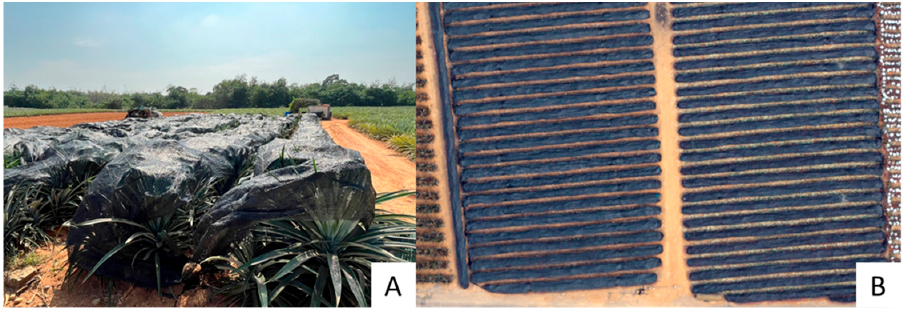
Figure 9. Photos of pineapples covered with nets from different perspectives: ( A ) in situ photos; ( B ) UAV image with GSD 3 cm. Table 4. Parameters of net detection with Mask R-CNN during the training process.